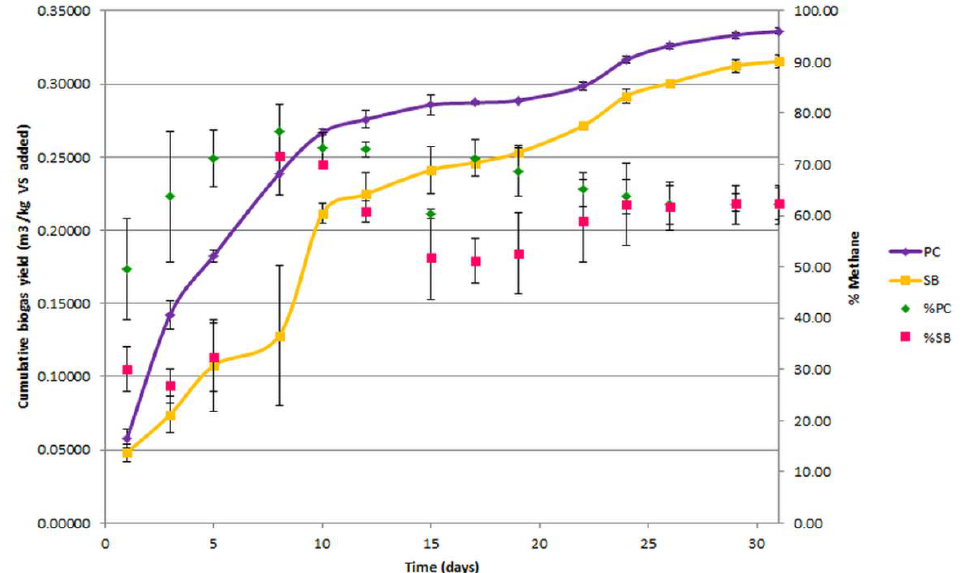
Figure 1. Cumulative biogas generation and methane composition during the thermophilic anaerobic digestion. The experiments were done in triplicate and values are shown as the mean ± standard deviation. The dark purple colored line and the green dots correspond to the positive control, PC, while the yellow line and the pink dots correspond to the substrate,